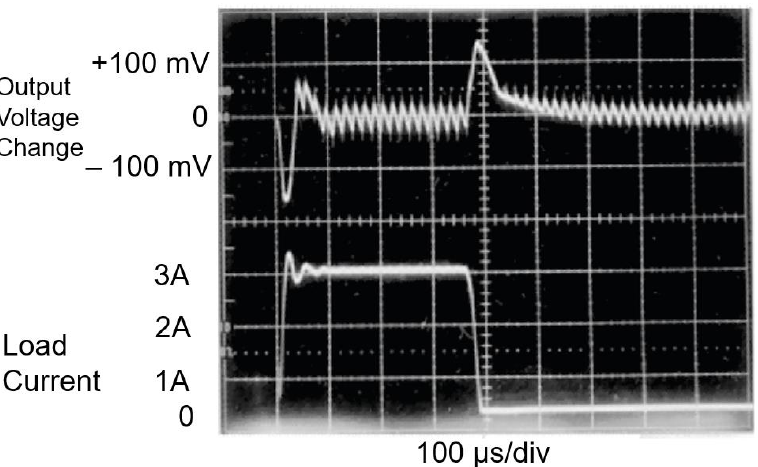
Figure 8. Main graph curves of the converter model with LM2576 regulator during its dynamic operation obtained by simulation.